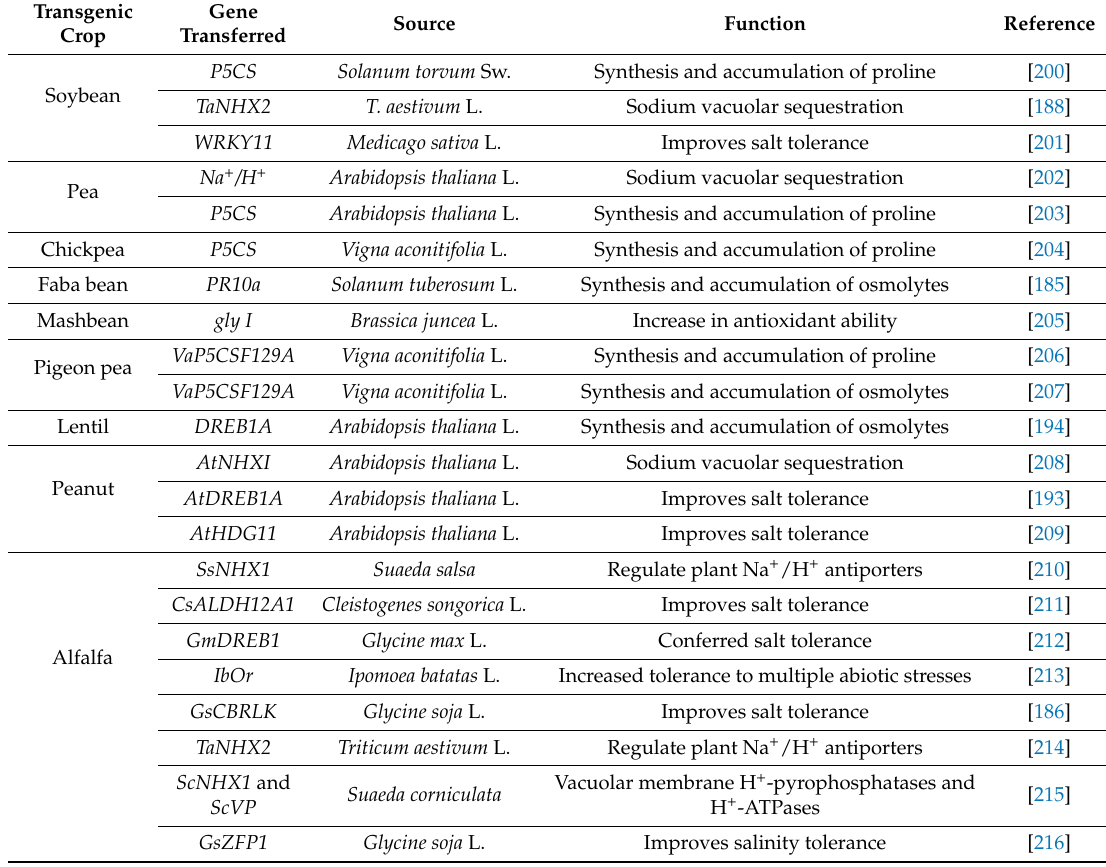
Table 2. Transgenic legumes for better salt